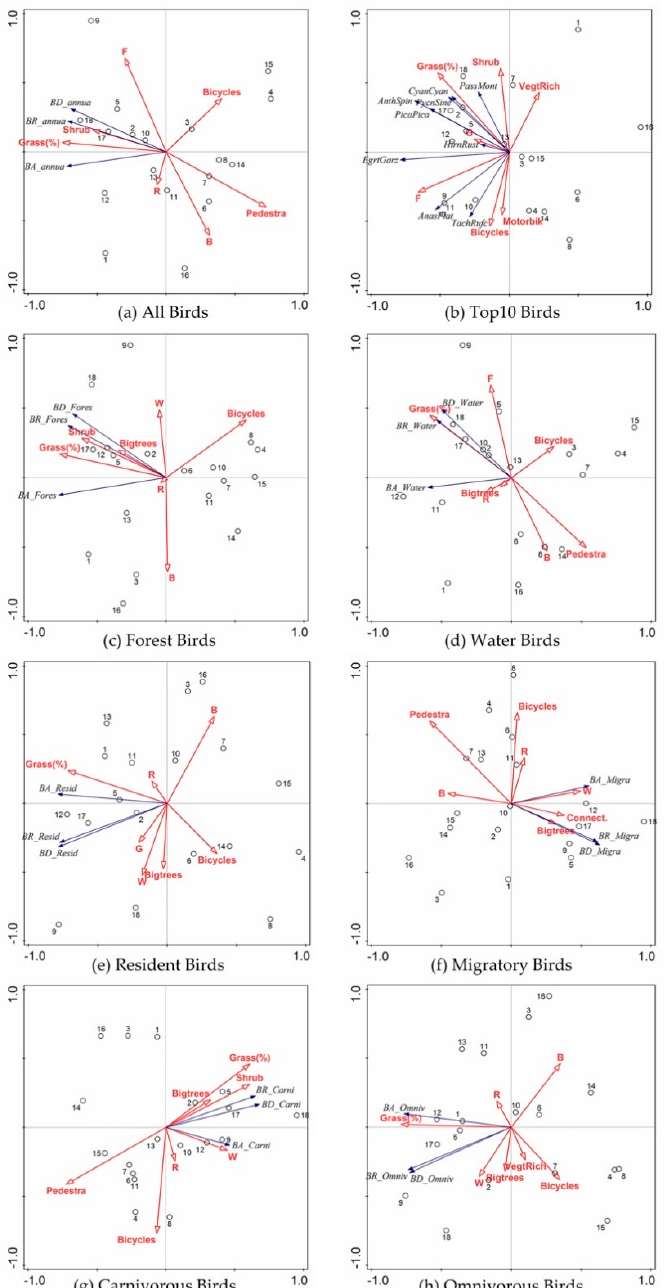
Figure 5. Redundancy analysis tri-plots showing correlation between environmental variables and avian biodiversity, including: ( a ) all birds; ( b ) the top 10 birds; ( c ) forest birds; ( d ) water birds; ( e ) resident birds; ( f ) migratory birds; ( g )carnivorous birds; ( h ) omnivorous birds. Seven local-scale variables and six landscape-scale variables were involved in the analysis: Grass = the coverage of grass; Shrub = the coverage of shrub; VegtRich = the vegetation richness; Bigtrees = the number of big trees; Pedestra = the number of pedestrians; Bicycles = the number of bicycles; Motorbik = the number of motorbikes; F = forest land; W = water area; G = grassland; B = building; R = road; Connect. = landscape connectivity. Three biodiversity indices: BA = bird abundance; BR = bird richness; BD = bird diversity. The top 10 birds: Passer montanus (PassMont), Anas platyrhynchos (AnasPlat), Cyanopica cyana (CyanCyan), Pica pica (PicaPica), Tachybaptus ruficollis (TachRufc), Hirundo rustica (HirnRust), Corvus dauuricus (CorvDauu), Anthus spinoletta (AnthSpin), Pycnonotus sinensis (PycnSine), Egretta garzetta (EgrtGarz).